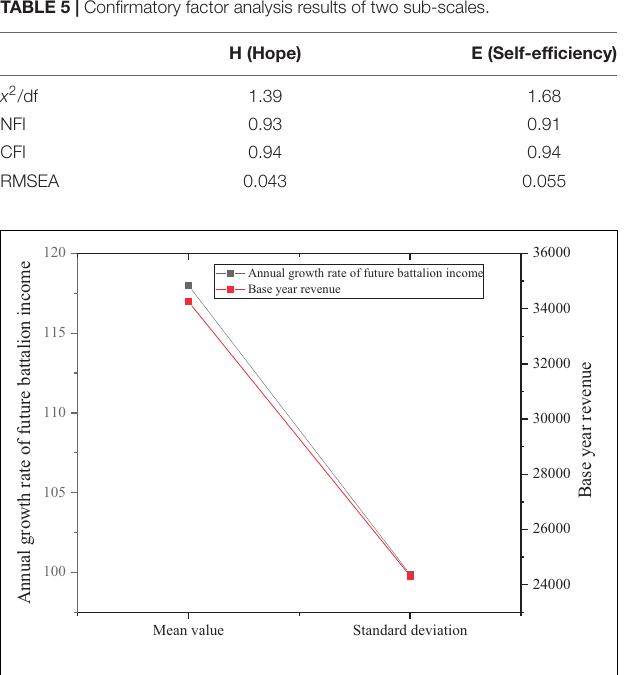
FIGURE 10 | Base year revenue and average annual growth rate of future